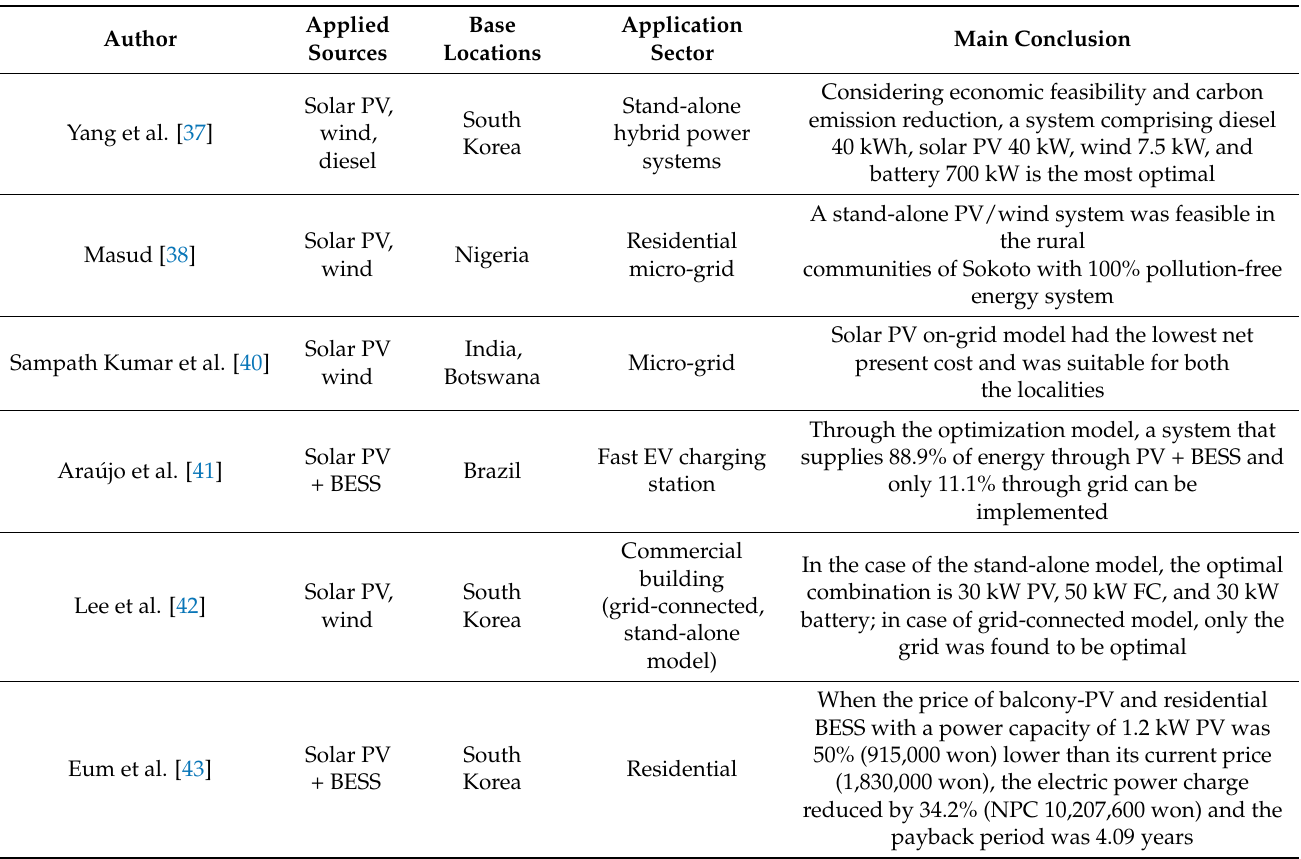
Table 3. Summary of research related to economic analysis of renewable energy power generation systems using